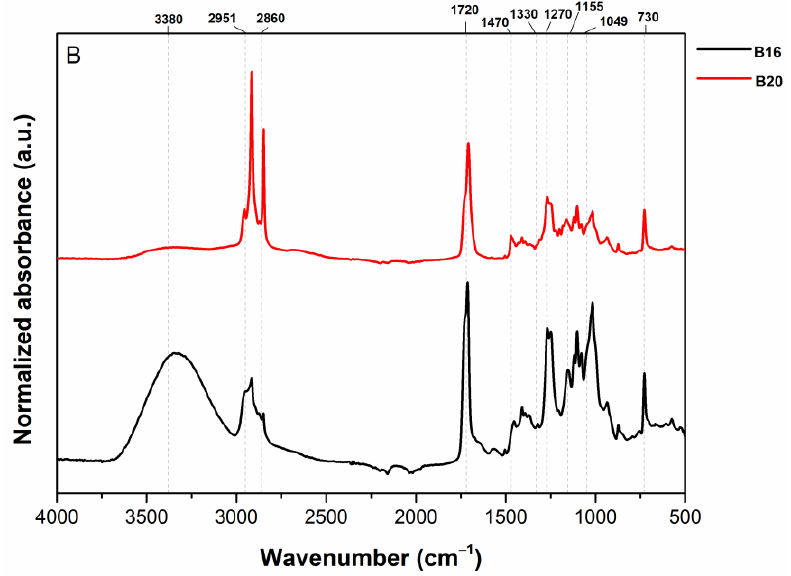
Figure 2. FTIR spectra of B16 and B20 samples.